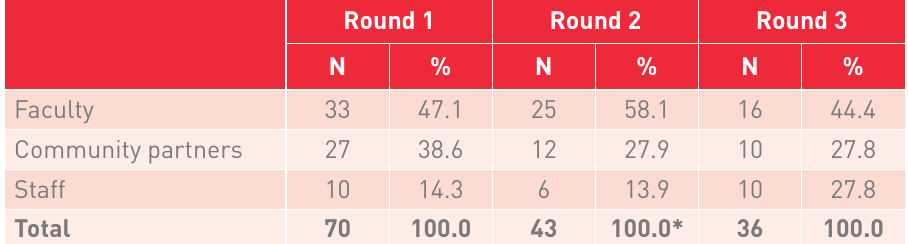
Respondent rate Round 1 Round